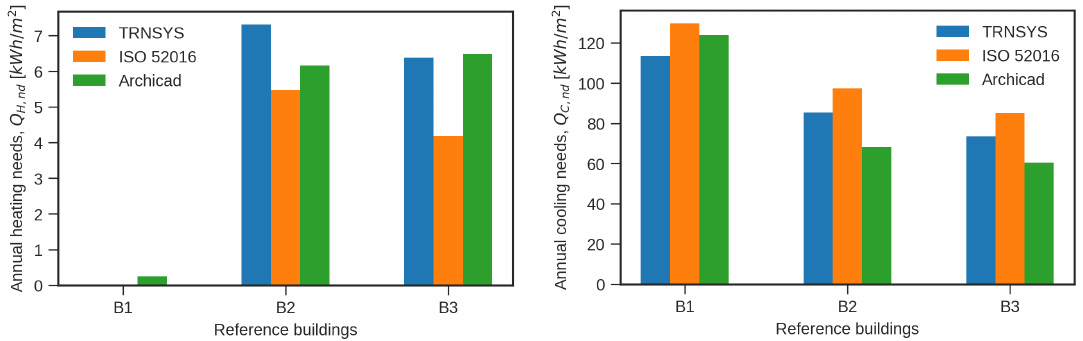
Figure 12. Annual heating and cooling needs for analyzed buildings in littoral climate for three types of energy simulation: TRNSYS ( blue ), ISO 52016-1:2017 (ISO 52016, orange ), and Archicad Energy Evaluation tool (Archicad, green